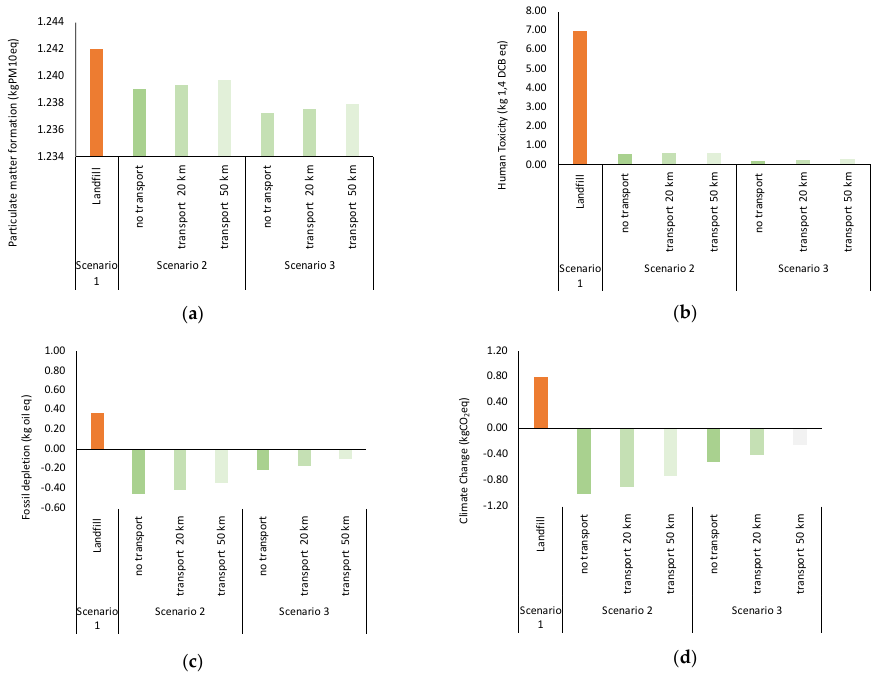
Figure 5. Sensitivity analysis of the environmental impacts in ( a ) Particulate ma tt er formation, ( b ) Human toxicity, ( c ) Fossil depletion, and ( d ) Climate change categories of impact (ReCiPe2016 Mid- point (H)) for Scenario 1 (GS disposal in land fi lls), Scenario 2 (GS valorised as a substitute for feld- spar in ceramic materials), Scenario 3 (GS valorised as a substitute for fi ne–medium inert fi ller in concrete mix) considering transport at 20 km and 50 km distance from the sawing plant. All values are referred to the functional unit 1 m 2 granite slab. (Cut-o ff 0.1%). Regarding the economic cost, the sensitivity analysis showed that the transport of GS may be responsible for an increase in the total cost from 1.96% and 1.84% (20 km) to 3.81% and 3.56% (50 km) in Scenarios 2 and 3, respectively. Transport distances longer than 40 km generate costs higher than the GS disposal in the land fi ll for both Scenarios 2 and 3 (Figure 6).